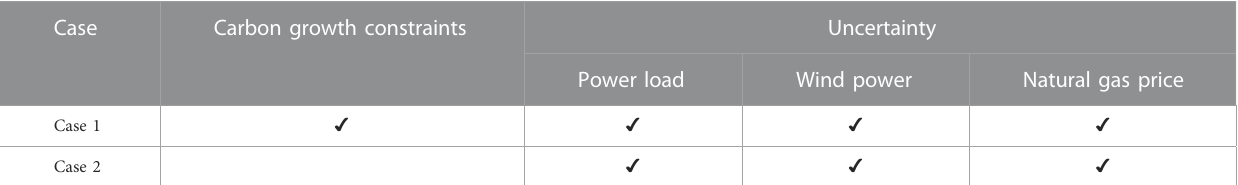
TABLE 7 Carbon constraint effect analysis